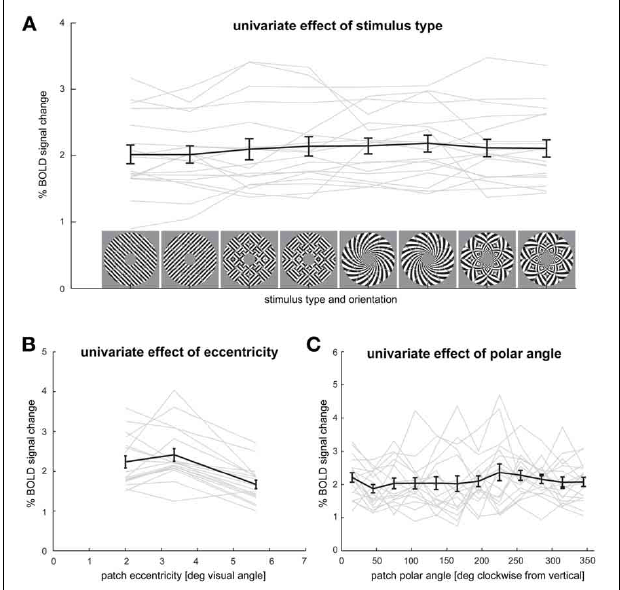
FIGURE 7 | Effects of stimulus type, eccentricity, and polar angle on average V1 responses. (A) Spatial-mean V1 activation for each stimulus type and orientation. (B) V1 response for each of the three patch eccentricities. (C) V1 responses for each of the 12 polar angles. Responses are averaged across the remaining variables (stimulus type, V1 patches, participants). Error bars indicate the SEM computed across participants. Gray lines depict each individual participant’s